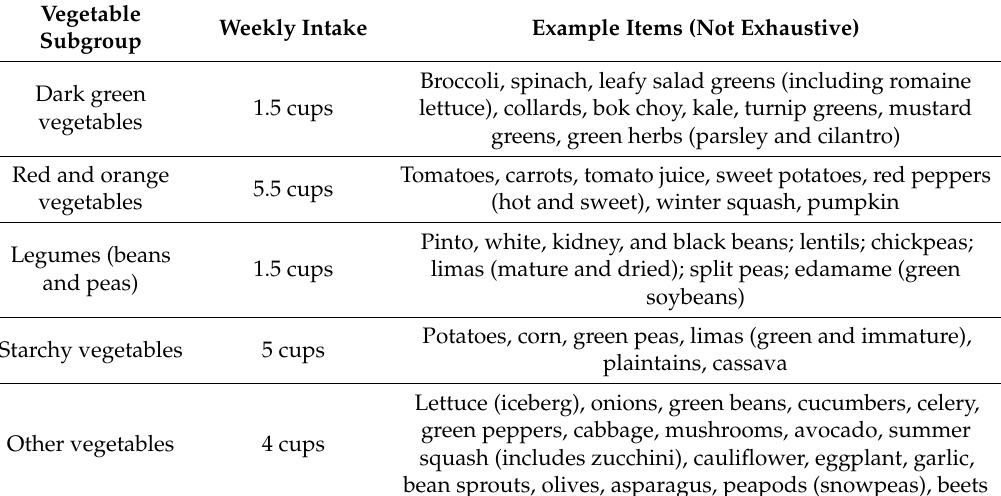
Table 1. Vegetable subgroup weekly recommendations for a 2000 calorie diet and examples from the Dietary Guidelines for Americans